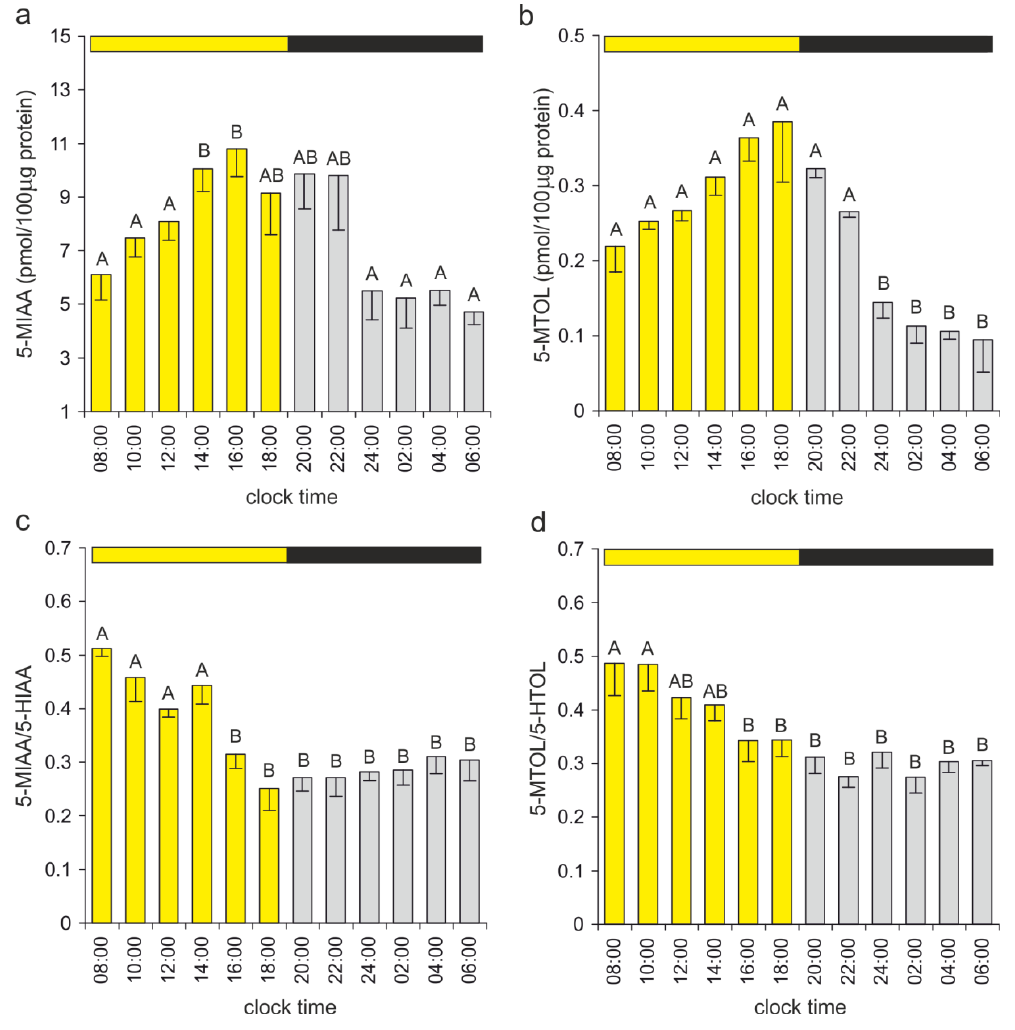
Figure 7. Methylated derivatives of indoles formed by 5-HT oxidative deamination. ( a , b ) The 5-MIAA and 5-MTOL contents and ( c , d ) the 5-MIAA/5-HIAA and 5-MTOL/ 5-HTOL ratios in the duck pineal organs taken at two-hour intervals over a daily cycle (means and standard errors, n = 5). For explanations, see Figure